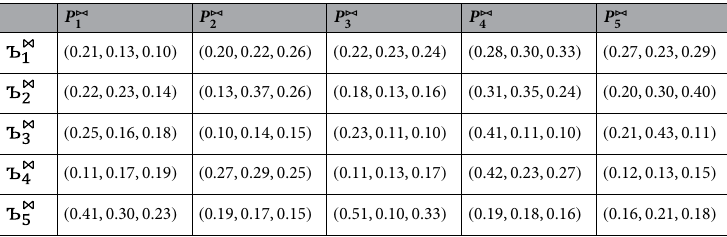
Table 1. Picture fuzzy soft data for F